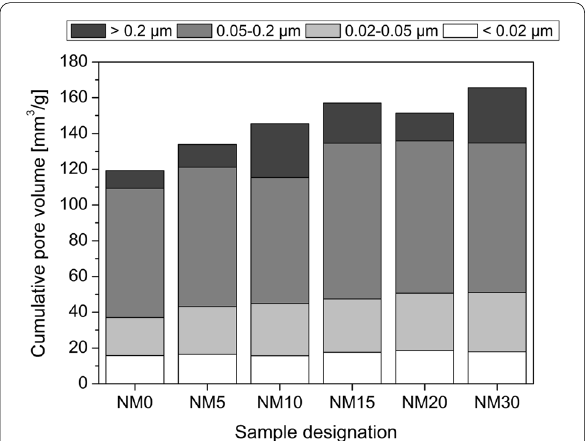
Fig. 4 Cumulative pore volume of cement pastes with pore division